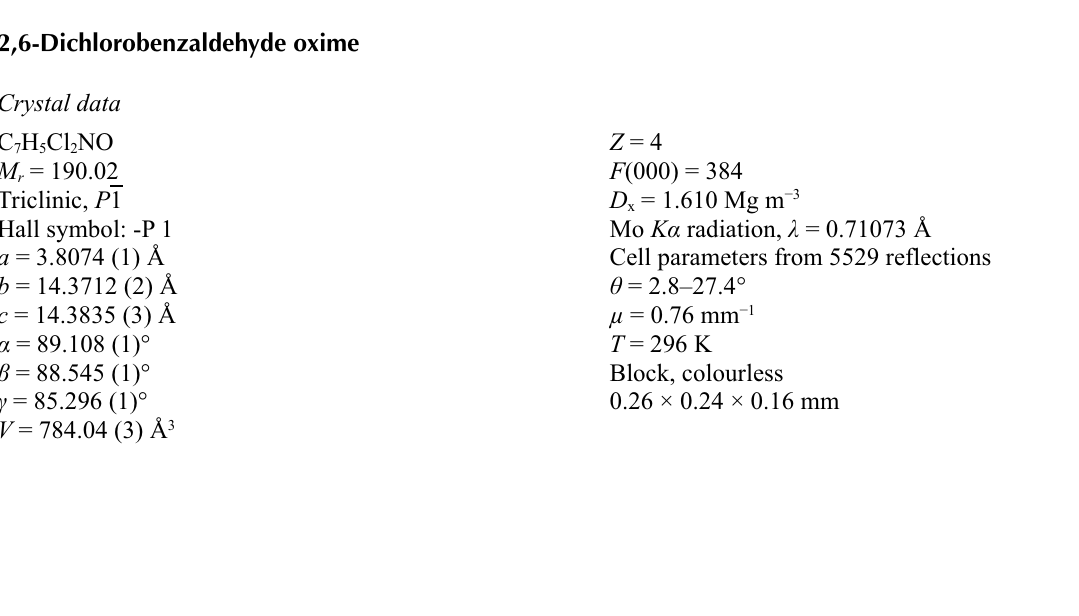
Partial packing view of compound ( I ), showing the formation of dimer through R 22 (6) graph set motif. H bonds are represented as dashed lines. H atoms not involved in hydrogen bonding have been omitted. [Symmetry codes: (i) -x, - y+1, -z+2; (ii) -x+1 , -y+2,